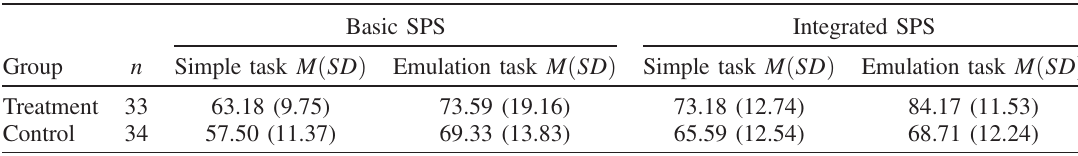
TABLE VI. Results of the correctness percentage of SPS in two inquiry